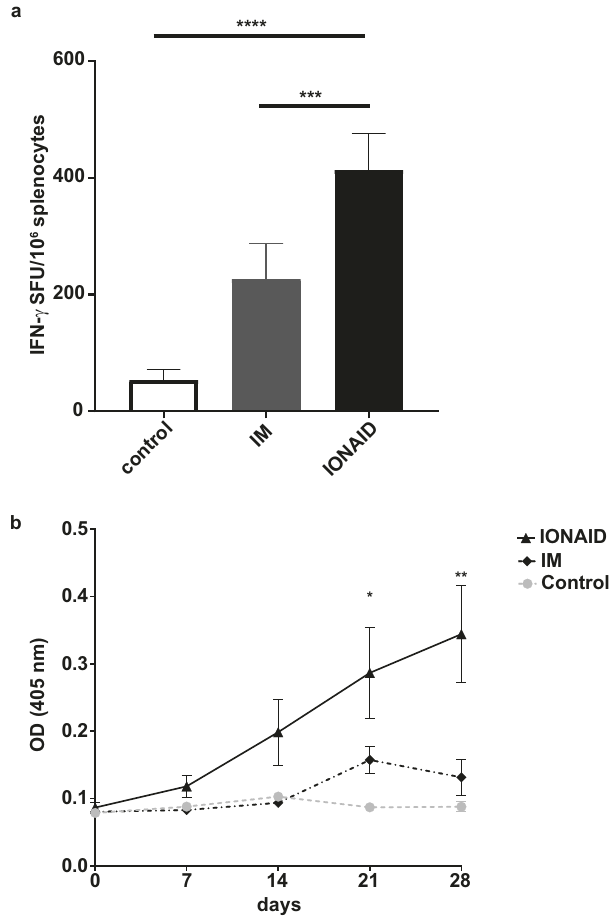
Fig. 3 ZGP-enhanced immune responses by IONAID in mice. a ZGP-speci fi c IFN- γ responses in groups of C57BL/6 mice ( n = 3/ group) after vaccination with 100 µg of pIDV-II-EboV-GP-M06 as measured by ELISpot assay. Splenocytes were puri fi ed at day 10 after immunization and stimulated with a pool of peptides from GP/ Mayinga-76 of Zaire Ebola virus. Results are expressed as